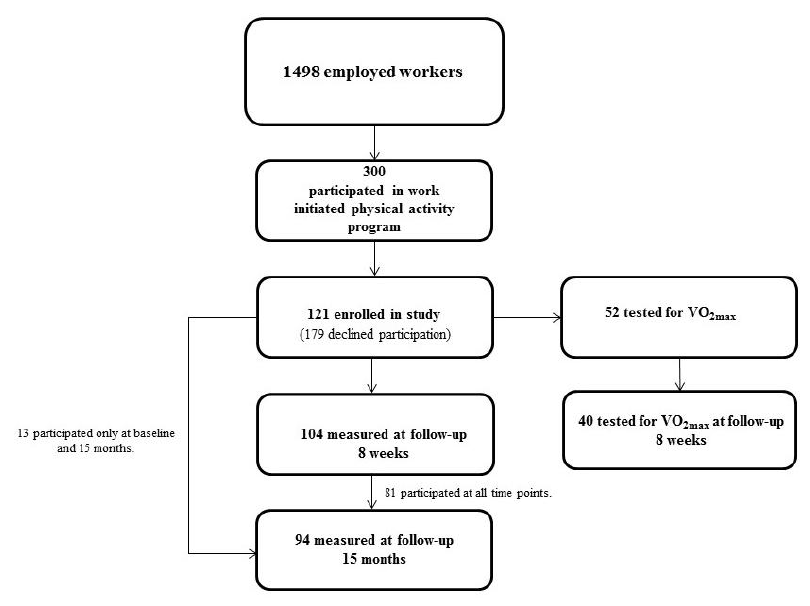
Figure 1. Flow diagram for the study. Table 1. Characteristics at baseline among females and males participating in the study.